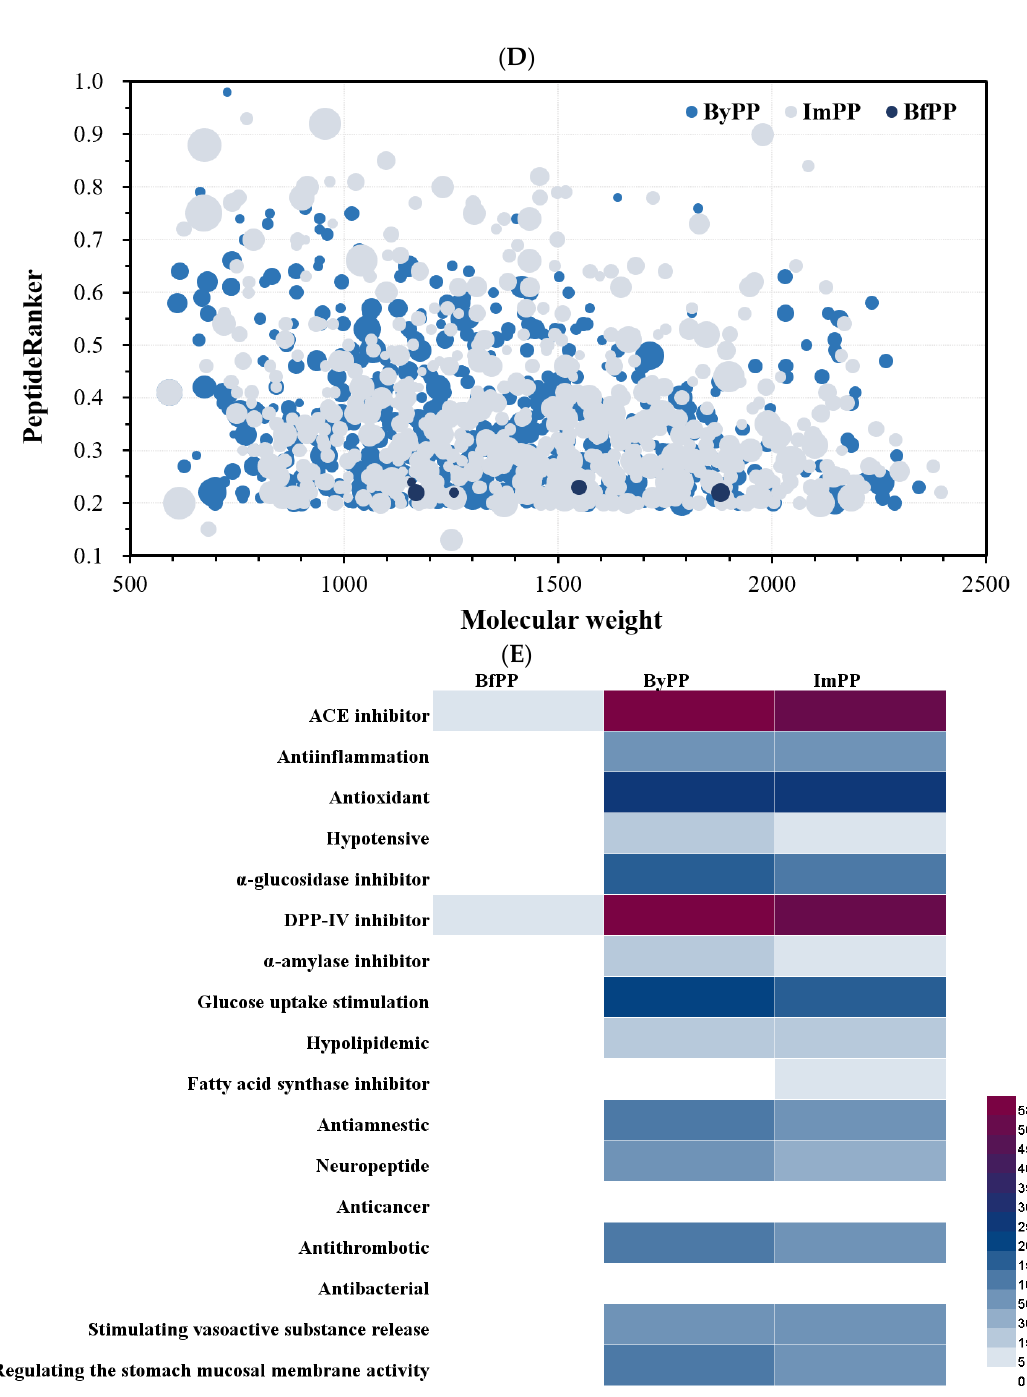
Figure 3. The peptide profile and virtual prediction of PBMA hydrolysates. ( A ) The distribution of peptides identified from BfPP, ByPP and ImPP. ( B ) Distribution of the potent peptides according to their origin proteins in BfPP, ByPP and ImPP. ( C ) Number of potent peptides fragment and their repetitions of each type released, and the bubble size represents the repeat numbers. ( D ) Molecular weight and PeptideRanker score of potent peptides, and the bubble size represents the CPPpred.